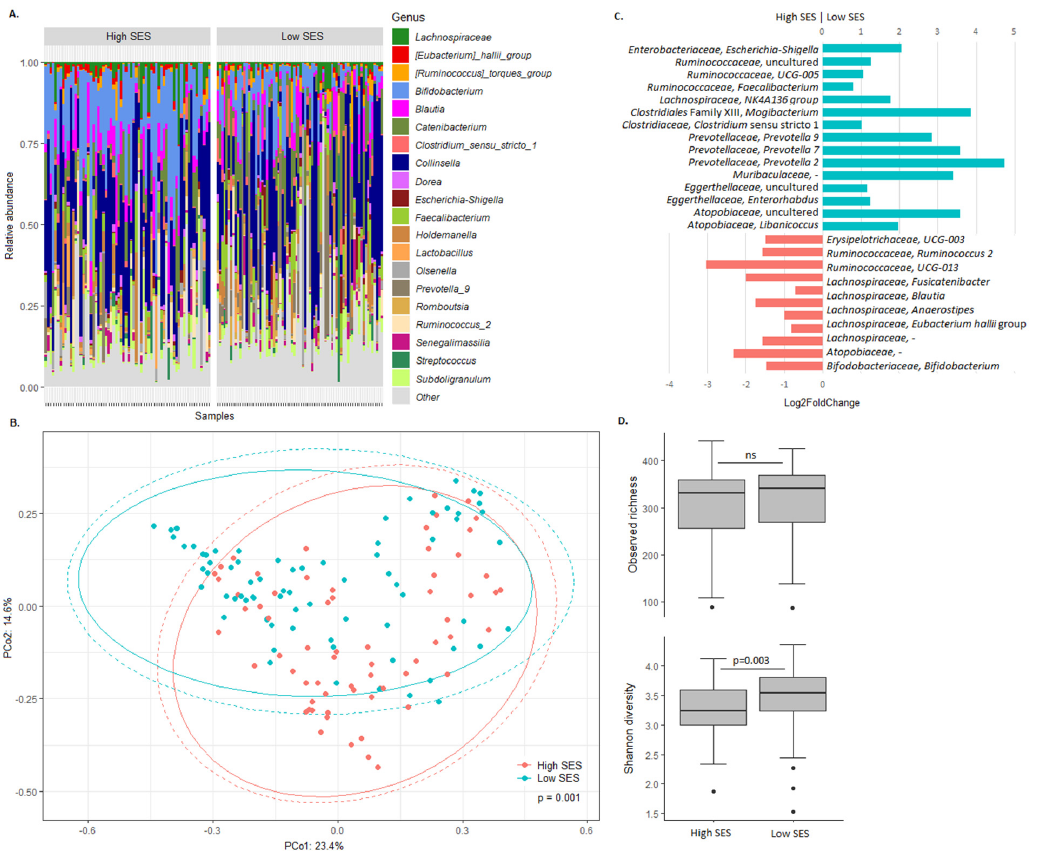
Figure 1. Association between the bacterial gut microbiota and SES. ( a ) Taxonomic profiles of the gut microbiota of high and low SES children. The 20 most abundant bacterial taxa are shown. Relative abundance of all other taxa is summed and labelled as ‘other.’ ( b ) The Bray–Curtis dissimilarity-based principal coordinate analysis plot labelled according to SES. Ellipses indicate confidence assuming a multivariate t-distribution (solid line) or a multivariate normal distribution (dotted line). ( c ) Differential abundance of bacterial taxa between high and low SES children. Taxa with Benjamini–Hochberg corrected p -value below 0.05 are shown. ( d ) Alpha diversity in high and low SES children. Boxplots show the median, 25th and 75th percentiles, and minimal and maximal values with the exception of outliers (black circles).